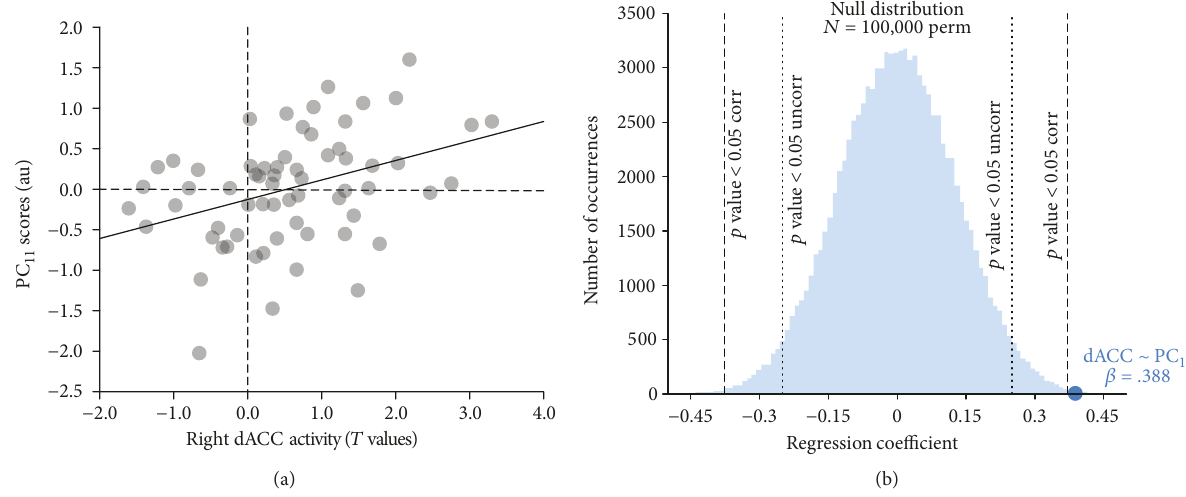
Figure 5: Predictive power of brain activity on cognitive pro fi le. (a) Scatter plot depicting the relationship between hemodynamic activity of the right dorsal anterior cingulate cortex (dACC) and the cognitive pro fi le expressed by the 11th component (PC), related to subjects ’ spatial attention and search abilities (i.e., scores at the Trail Making Test A versus delayed recall of the Babcock story). (b) Null distribution of regression coe ffi cients against which the relationship between right dACC activity and cognitive pro fi le expressed by the 11th component was tested. The blue dot indicates the actual relationship between the right dACC and the 11th PC; dotted lines represent p value < 0 05 uncorrected threshold, while dashed lines represent p value < 0 05 Bonferroni corrected.